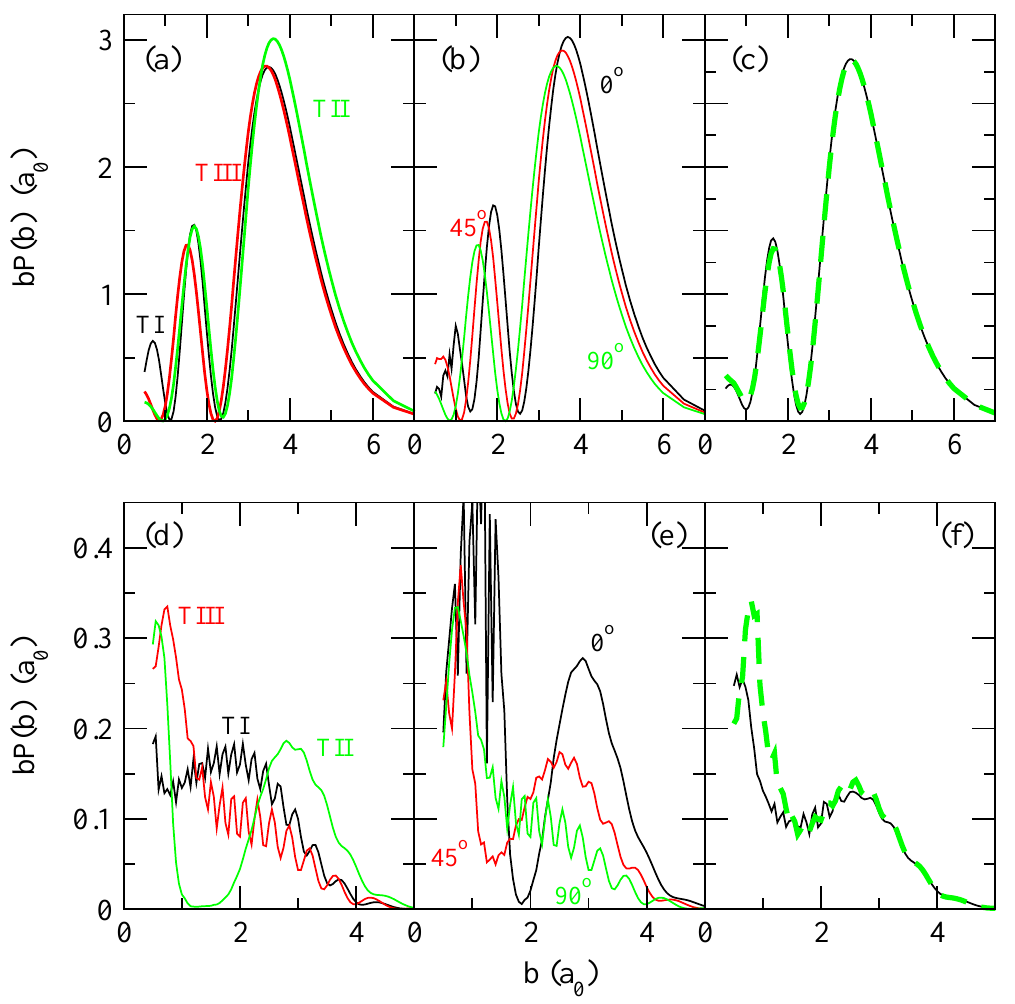
Figure 4: Charge transfer transition probabilities for E = 4 keV (panels (a,b,c)) and E = 62 . 5 eV (panels (d,e,f)). Panels (a) and (d): bP ct ( b ) for trajectories I, II y III, as indicated in the figure. Panels (b) and (e): bP ct ( b, γ ) for γ = 0 ◦ , 45 ◦ and 90 ◦ , as indicated in the figure. Panels (c) 0 0 iso and (f): Average of transition probabilities obtained with the isotropic approximation for several values of γ (dashed-thick lines) bP ct ( b ) (eq. (25)); average of transition probabilities obtained for 0 iso trajectories I, II and III (solid-thin line) bP ct ( b ) (eq.